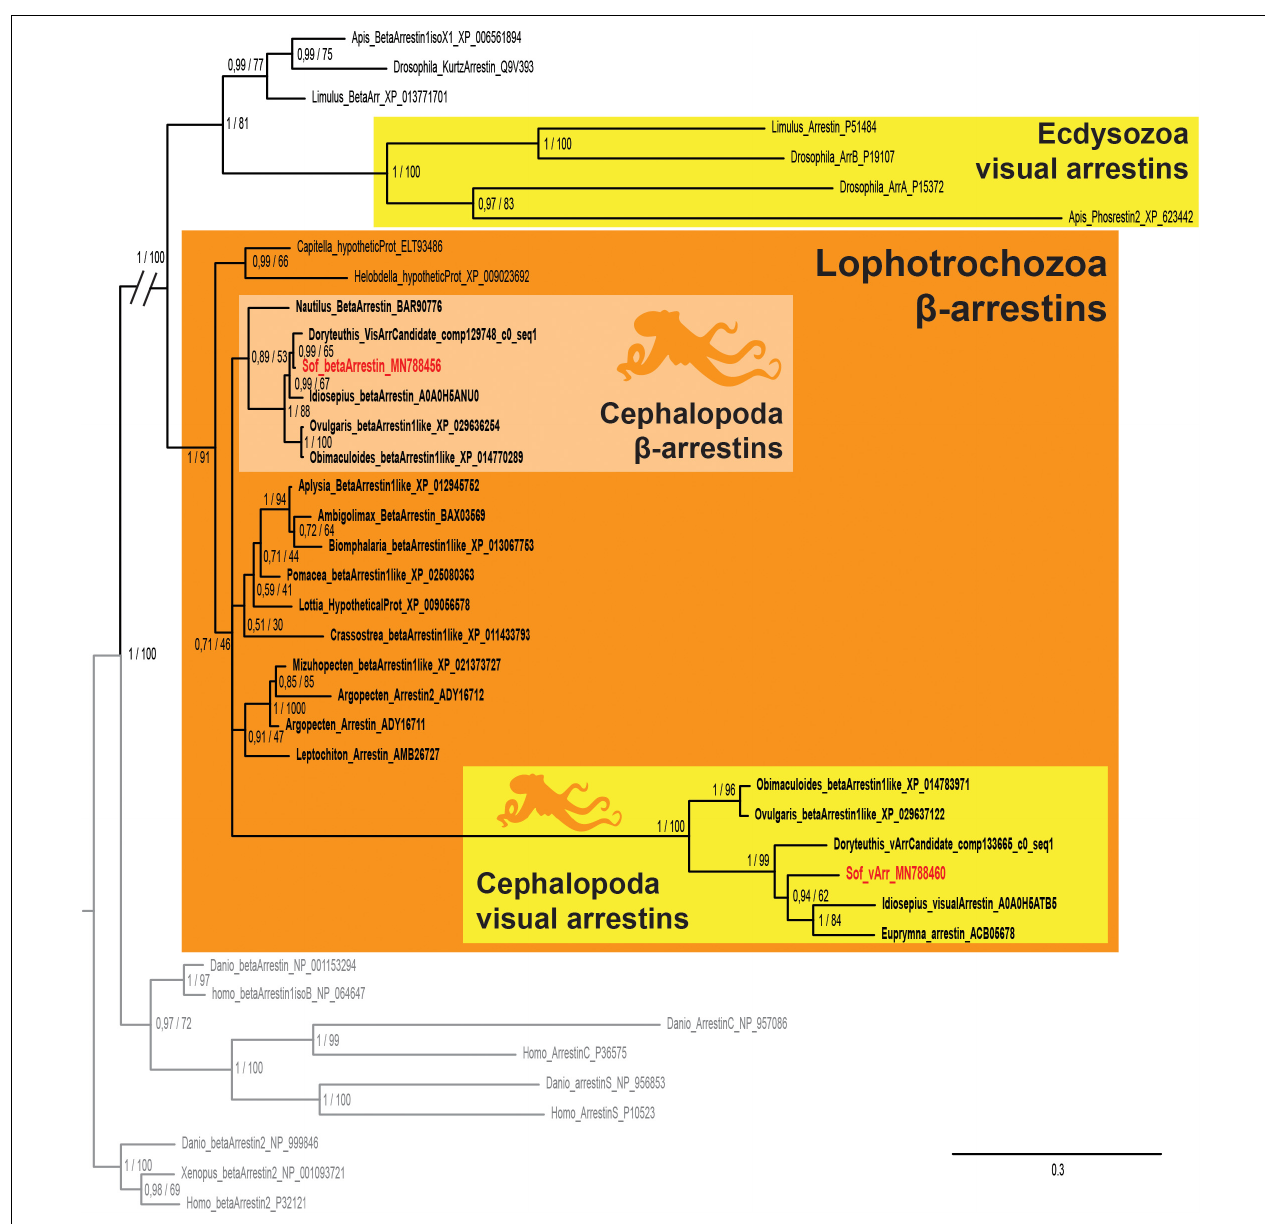
FIGURE 5 | Arrestin phylogeny. Phylogenetic analysis of 37 sequences of 325 amino acids generated in Bayesian Inference (Mr. Bayes v3.2.7a). Two groups of coleoid cephalopods arrestins are retrieved: visual arrestins (v-arr) in yellow and β -arrestins ( β -arr) in light orange. Ecdysozoan visual arrestins (or phosrestines) sequences are highlited (yellow), sequences from S. officinalis are in red, sequences from other molluscs are in bold font and outgroups (vertebrates β -arrestins 2 for rooting and other deuterostomians arrestins) are in gray. Nodes labels are posterior probabilities and bootstrap values (PP/BS). Lighter boxes with cephalopod silhouette [modified from Stöger et al. (2013)] represent groups of cephalopod sequences. The branch from the root to the ingroups and outgroups were shortened for more lisibility (//).